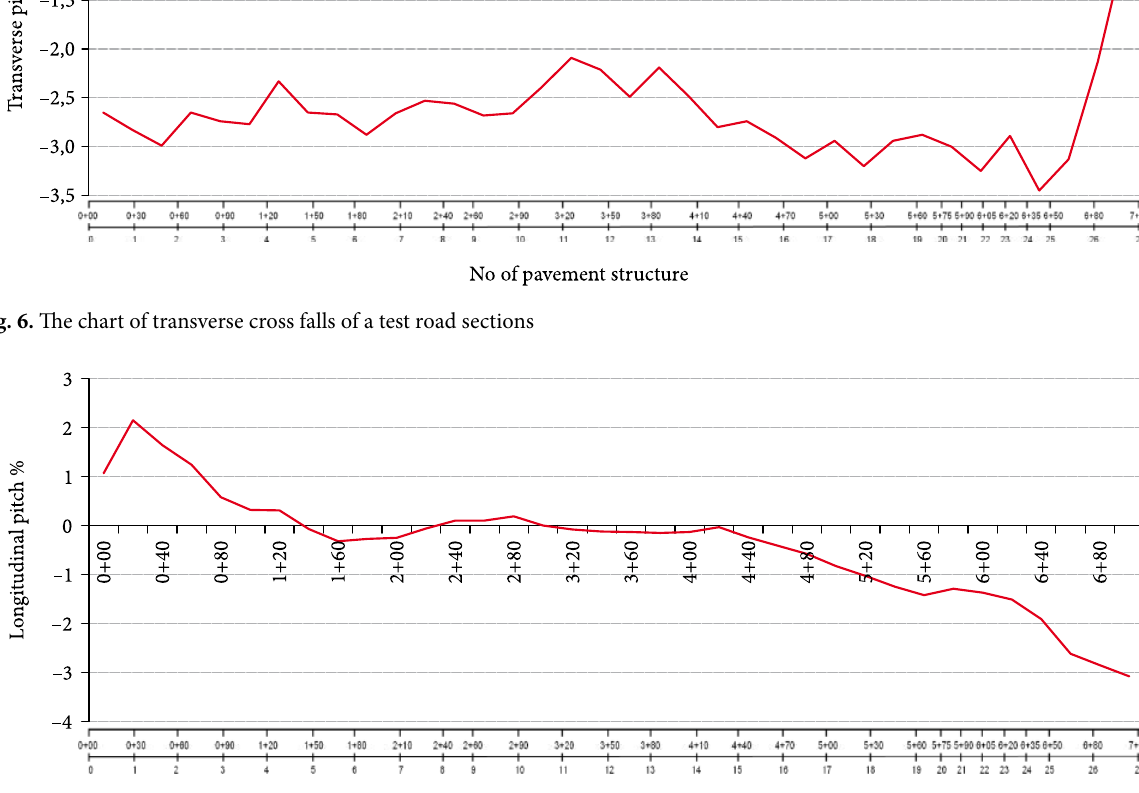
fig. 7. The chart of longitudinal cross falls of a test road